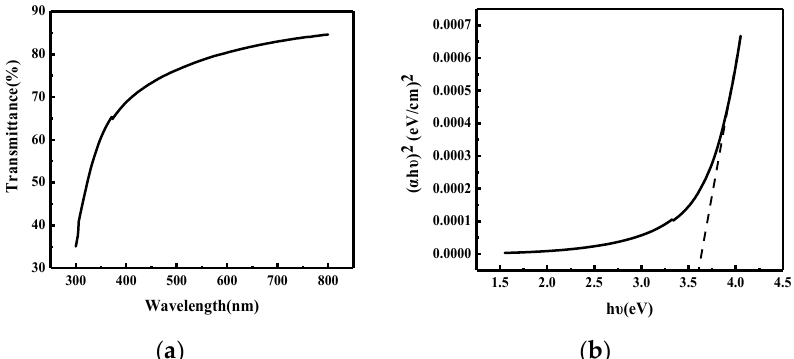
Figure 5. ( a ) Optical transmittance spectrum of SnO 2 :10 at.% Ga films; ( b ) The ( α h υ ) 2 versus h υ plots of SnO 2 :10 at.% Ga